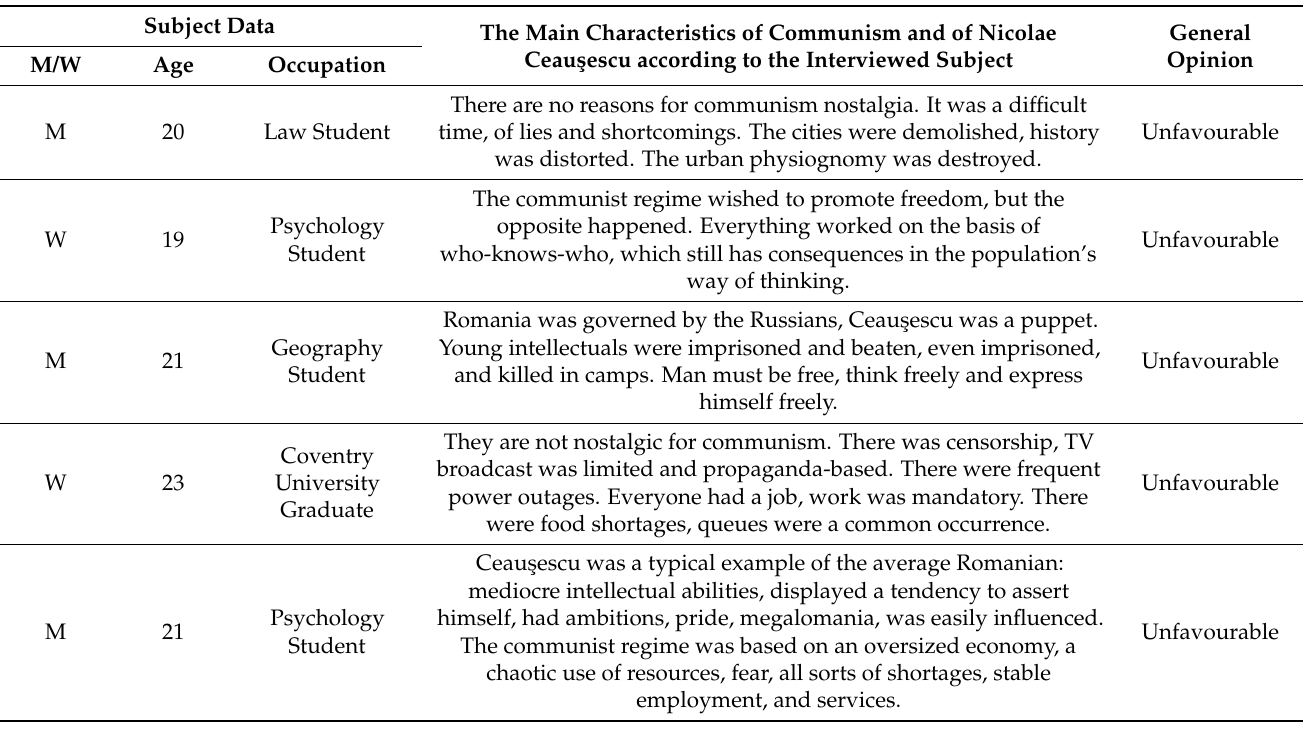
Table 3. The young generation’s perception of communism